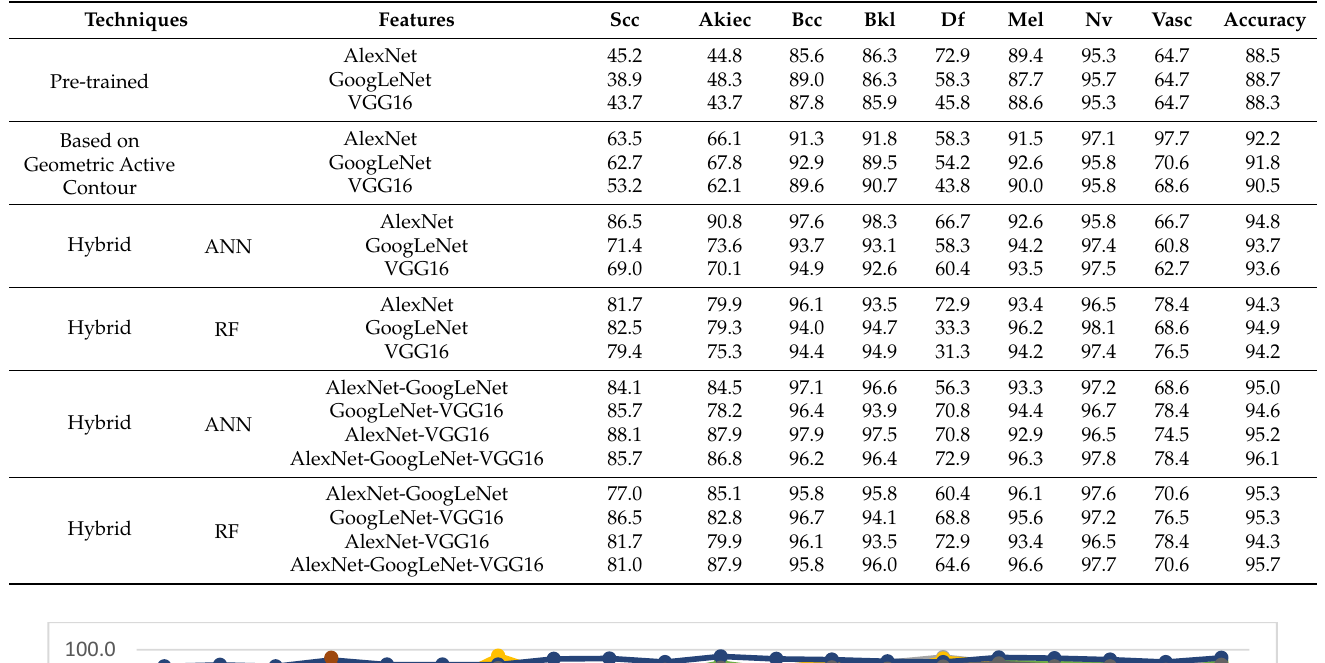
Table 9. Performance of proposed systems for dermatoscopic image analysis for early diagnosis of skin cancer for the ISIC 2019 dataset and distinguishing them from other skin lesions.